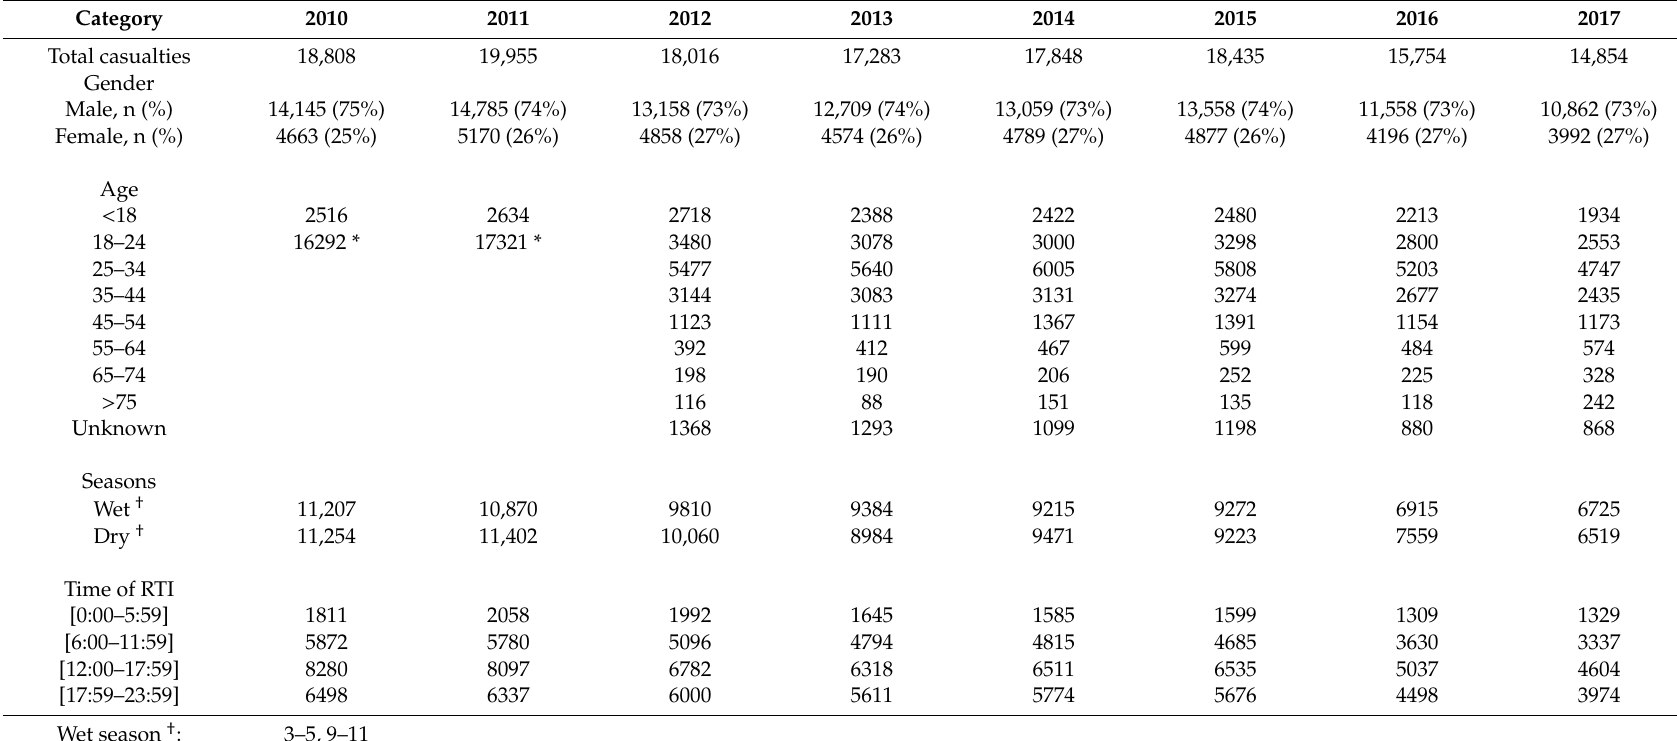
Table 1. Annual Ugandan police tra ffi c report